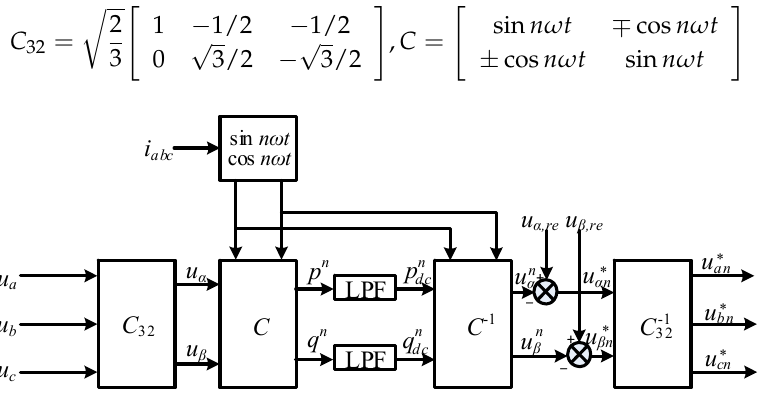
Figure 6. Schematic diagram of obtaining voltage compensation value.